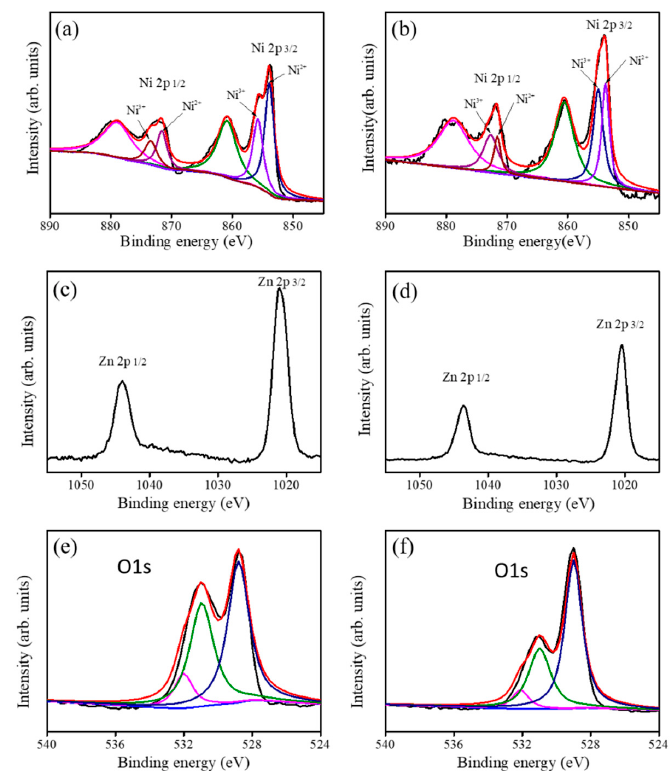
Figure 4. XPS analysis of the porous ZnO-NiO composite nanosheets: ( a ) Ni 2p narrow scan spectrum of the ZnO-NiO-1, ( b ) Ni 2p narrow scan spectrum of the ZnO-NiO-2, ( c ) Zn 2p narrow scan spectrum of the ZnO-NiO-1, ( d ) Zn 2p narrow scan spectrum of the ZnO-NiO-2, ( e ) O 1s narrow scan spectrum of the ZnO-NiO-1, ( f ) O 1s narrow scan spectrum of the ZnO-NiO-2.